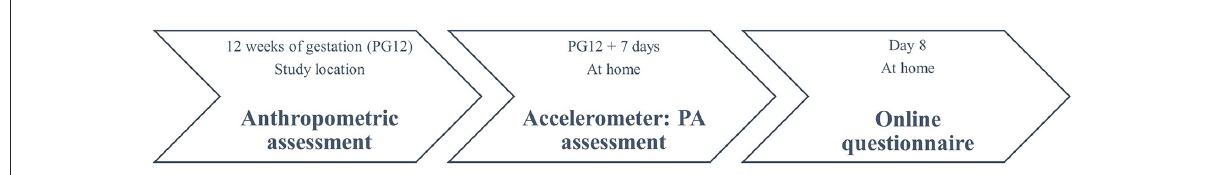
FIGURE1 Overview of different steps during data collection. Study location: participating hospitals or participant’s